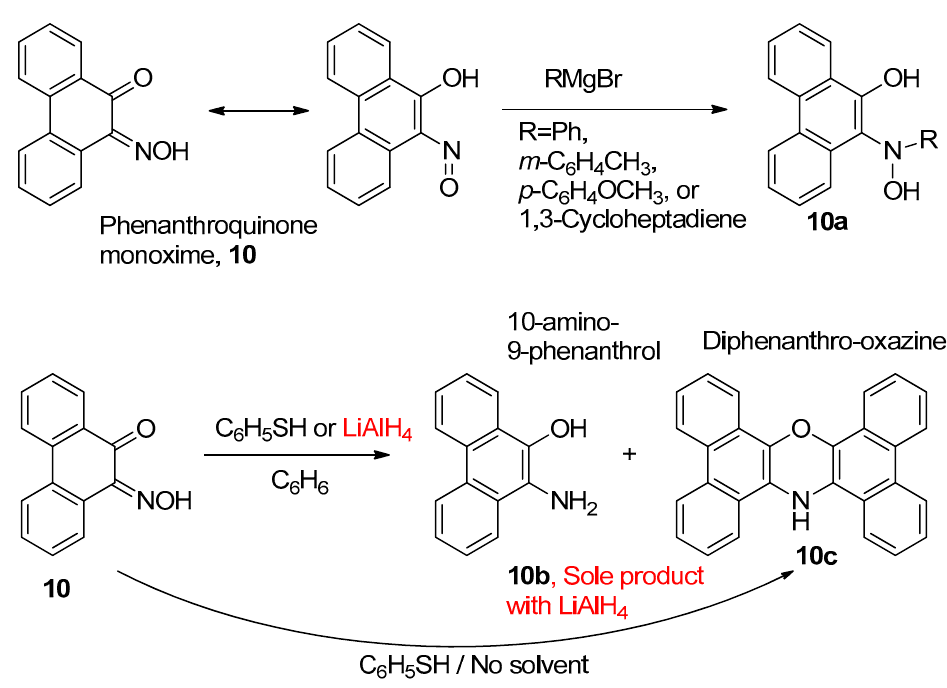
Figure 9. Reactions of Grignard reagents and reductions—Mustafa and Kamel [68].